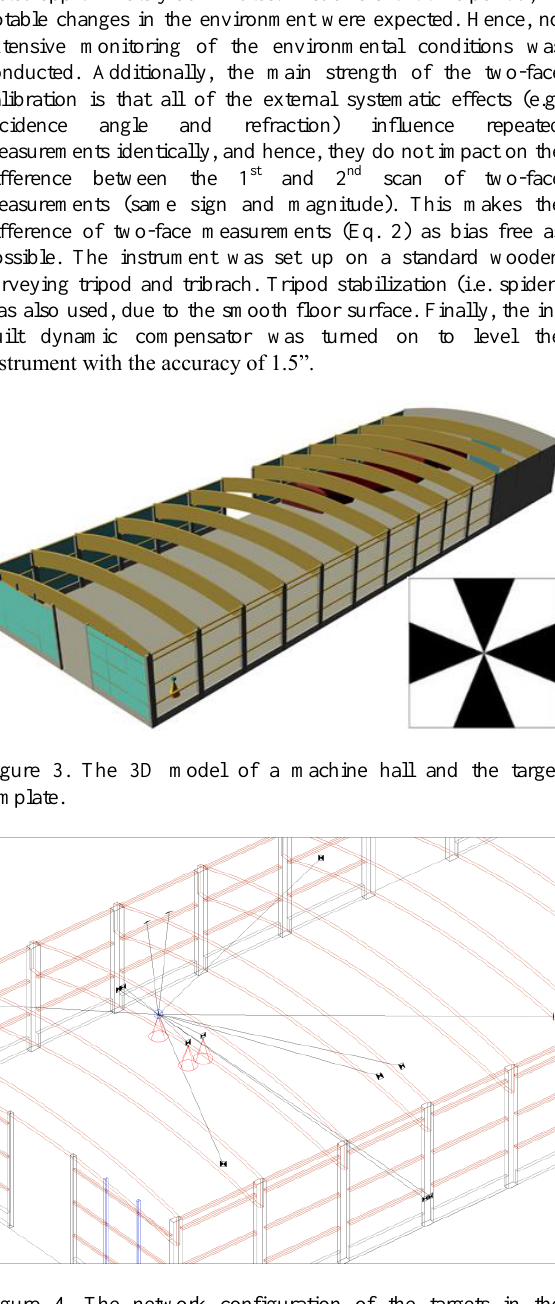
Figure 4. The network configuration of the targets in the machine hall w.r.t. the scanner station with the lines of